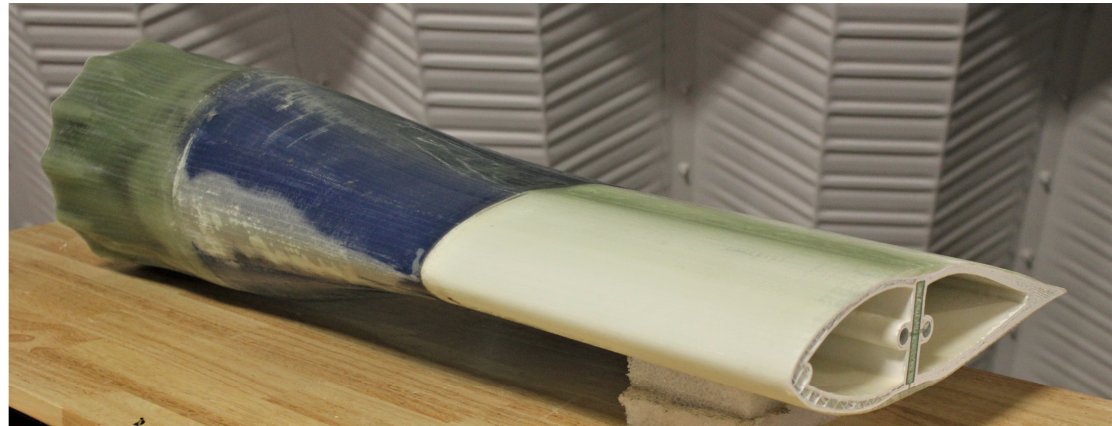
Figure 10. The final finished blade section with visible out-of-plane waves stemming from the root inserts and the delamination along the leading edge of the transition region.